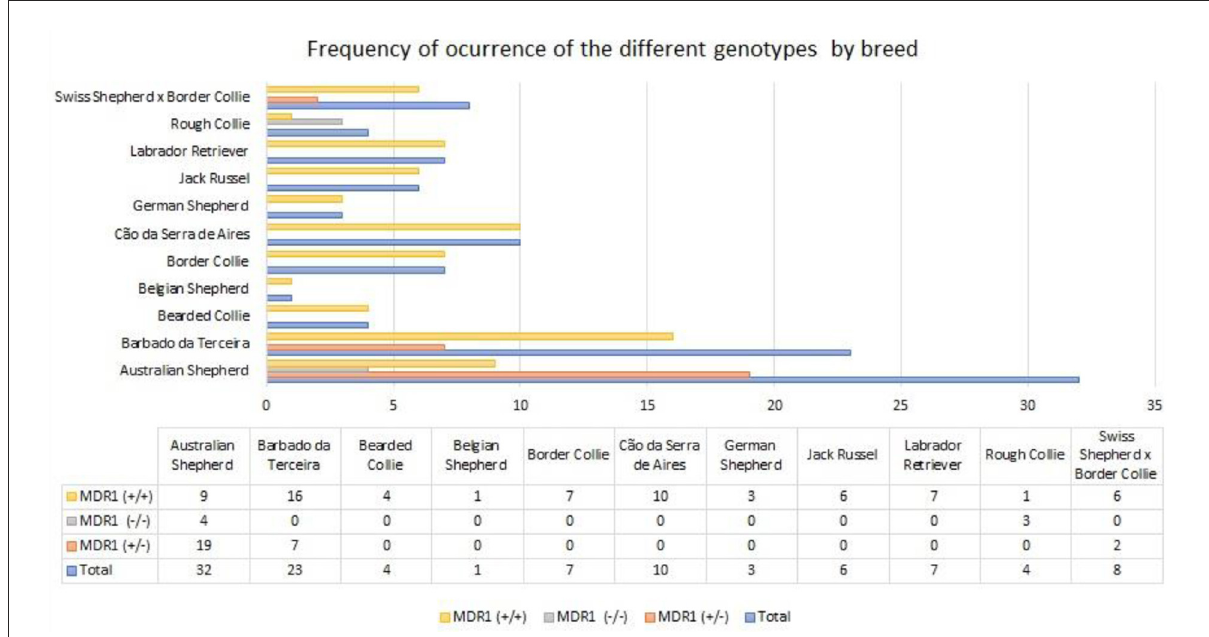
FIGURE1 Frequency of occurrence of the different genotypes by breed. MDR1 (–/–), genotype with two mutant alleles, homozygous for the deletion, MDR1 ( + /–), genotype with one wild type and one mutant allele, heterozygous for the deletion; MDR1 ( + / + ), genotype with two wild type alleles,